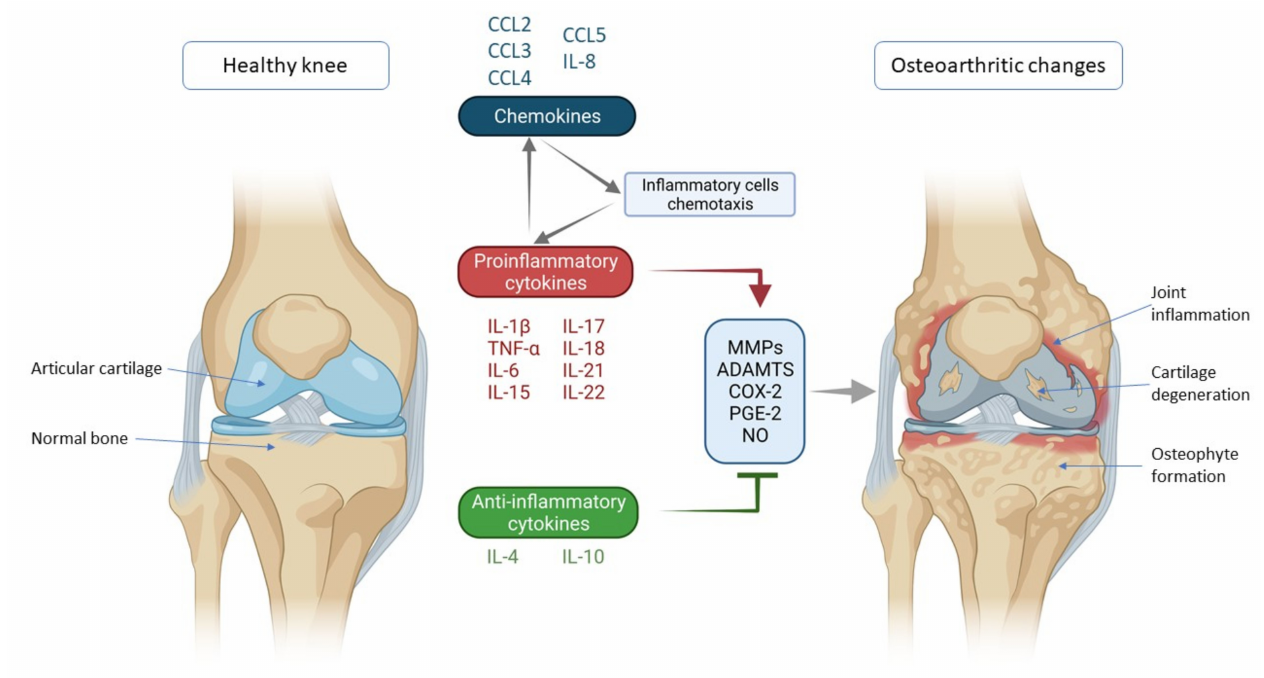
Figure 1. Schematic representation of key inflammatory processes and factors in osteoarthritis pathogenesis. The disturbed balance of proinflammatory and anti-inflammatory cytokines (in favor of proinflammatory cytokines) is responsible for the secretion of enzymes and other inflammatory factors involved in the pathogenesis of osteoarthritis leading to morphological changes within the joint such as cartilage degeneration, osteophyte formation and other inflammatory changes such as synovitis. Chemokines also contribute to inflammatory processes, stimulating the chemotaxis of inflammatory cells that then further secrete proinflammatory cytokines, thus creating a vicious circle that poses a major challenge in treating and slowing the progression of osteoarthritis. IL—interleukin; CCL-CC—chemokine ligand; TNF- α —tumor necrosis factor α